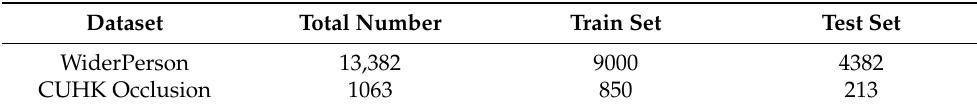
Table 2. Experimental data division for different data sets.